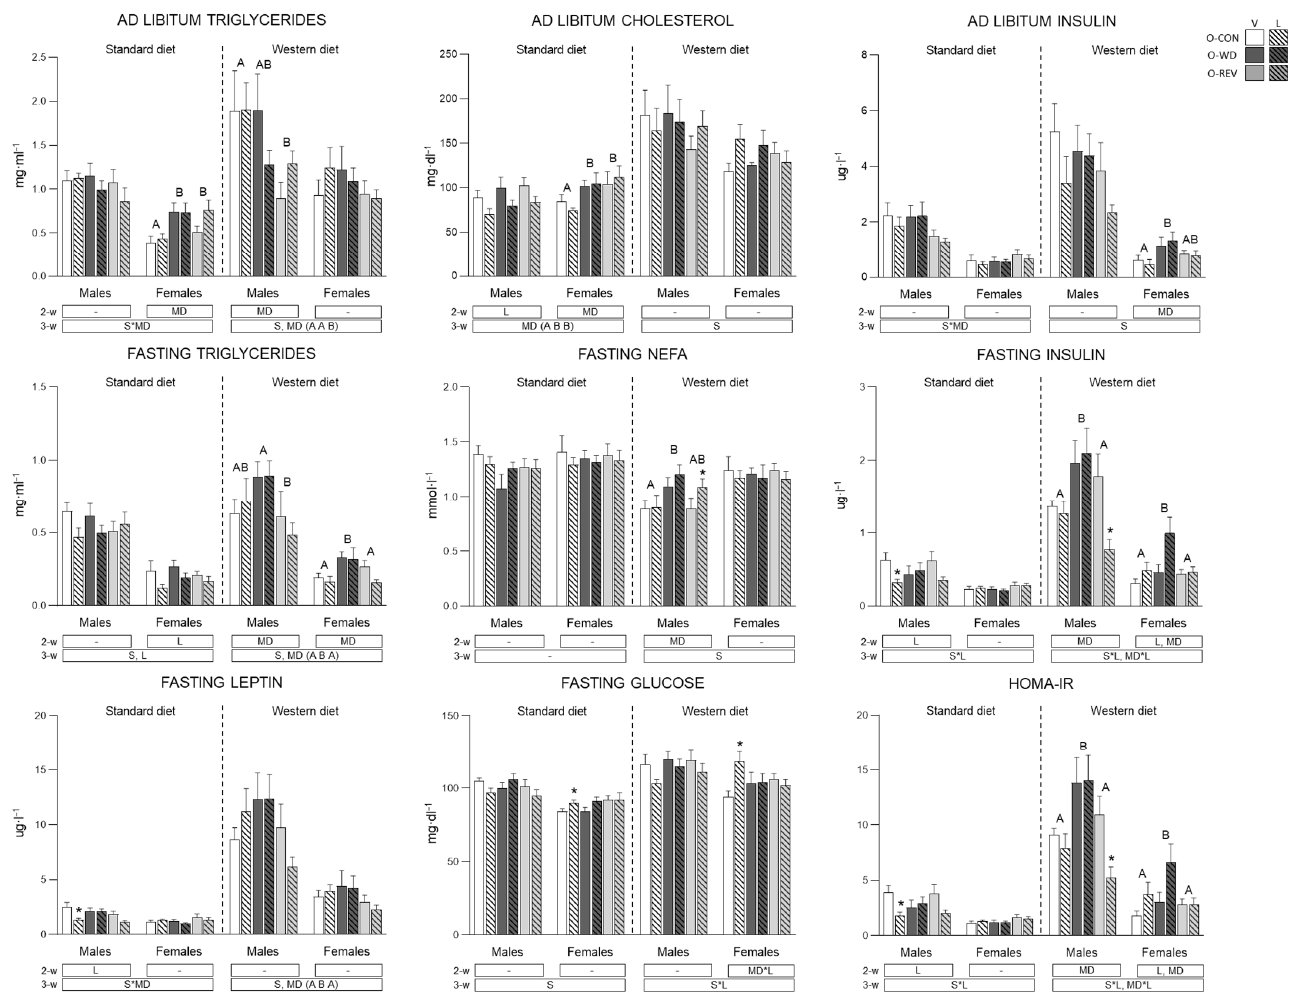
Figure 4. Circulating parameters and HOMA-IR of O-CON, O-WD and O-REV male and female animals treated with vehicle or leptin during suckling and fed SD or WD from weaning, under fasting (at three and half months) and ad libitum (four months) feeding conditions. Data are mean ± SEM ( n = 8–12). Statistics: After data separation depending on post-weaning diet, three-way ANOVA was performed to analyze the effect of sex, maternal diet and/or leptin treatment. In each sex, two-way ANOVA was performed to analyze the effect of leptin treatment and/or maternal diet. Single comparisons between leptin versus vehicle-treated rats of all experimental groups were carried out using Mann-Whitney U test. Symbols: sex (S), maternal diet (MD), leptin treatment (L); A ≠ B ( p < 0.05, LSD post-hoc, two-way ANOVA); *, different from their vehicle-treated equal ( p < 0.05, Mann-Whitney U test). Abbreviations: offspring of CON-dams (O-CON), offspring of WD-dams (O-WD), offspring of REV-dams (O-REV), vehicle (V), leptin